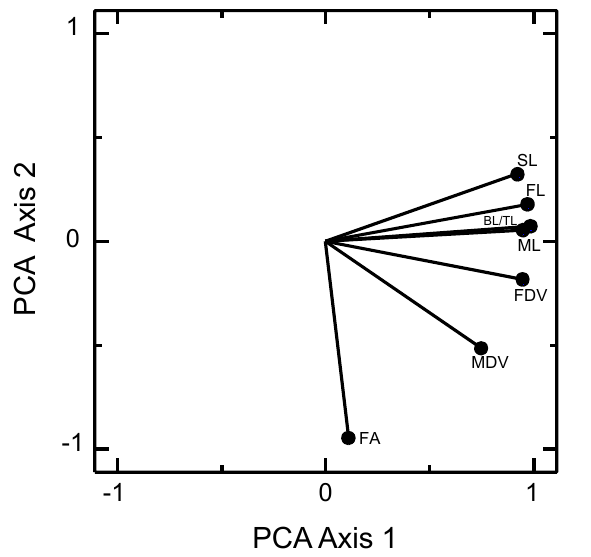
Fig. 3. Contribution (loadings) of morphological variables mea- sured on late-stage summer flounder larvae (28dph) to significant principal component (PC) axes. PC axis 1 accounted for 77% of overall variance and is dominated by measures of fish size (primar- ily length but also body depth measurements). PC axis 2 accounted for an additional 17% of the remaining variance and largely reflects developmental stage (degree of flexion) with additional contribu- tions by depth of body muscle mass. See Fig. 1 for abbreviations and Table S2 for summary statistics.